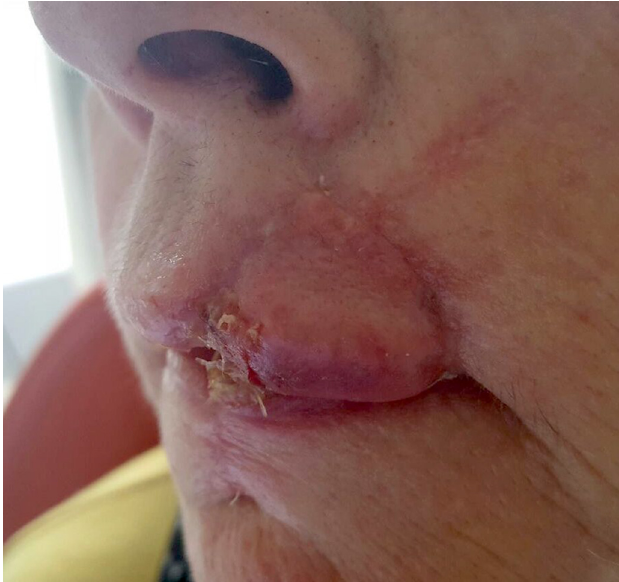
Fig. 5. Aspect of the scar 3 days after graft weaning.